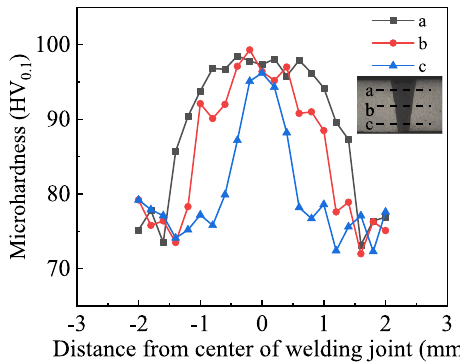
Fig. 9 Microhardness distribution in different areas of WE43 mag- nesium alloy EBW